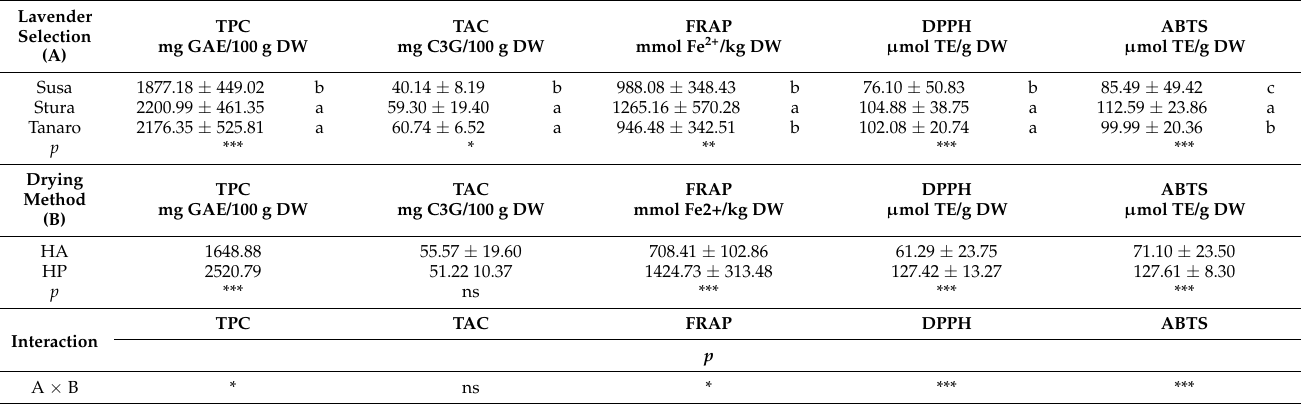
Table 2. Comparison of total phenolic content (TPC), total anthocyanin content (TAC), and antiox- idant activity (FRAP, DPPH, and ABTS assays) of L. angustifolia decoction according to the three selections (A), the drying method (B), and their interaction. HA = hot air dried; HP = heat pump dried. Data are based on dry weight